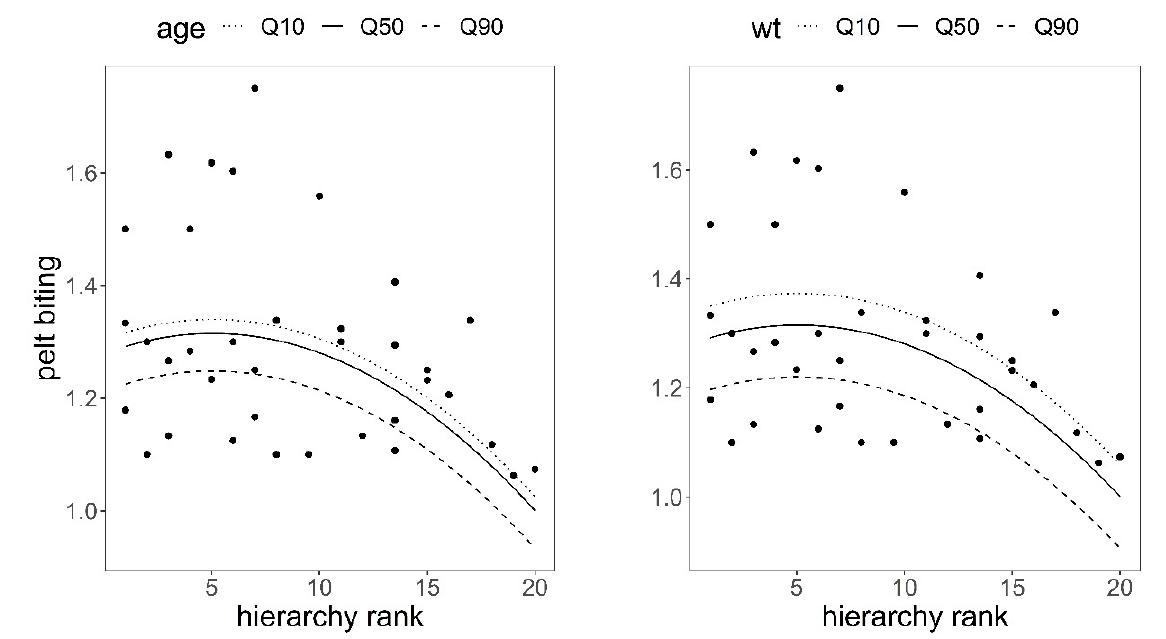
Figure 4. Predictions of the response of pelt biting to hierarchical rank in red deer hinds using model in Table 3. Variables not present in the plots were fixed to their means. Q10, Q50, and Q90 are 10, 50, and 90 quantiles. The higher the hierarchy rank, the higher the dominance. Table 4. Coefficients and statistics of a polynomial mixed model on the response of pelt biting to